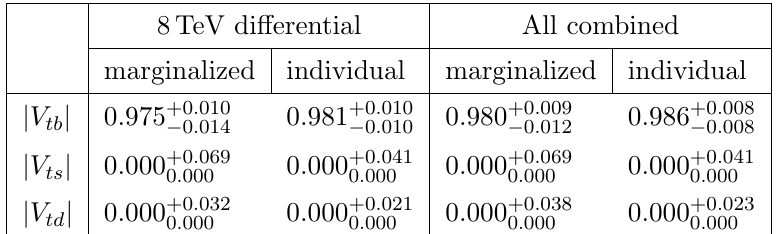
Table 3 . Observed individual and marginalized best (cid:12)t values together with 68% con(cid:12)dence interval for the j V td j , j V ts j and j V tb j CKM elements obtained from single top t -channel di(cid:11)erential cross section measurements at 8 TeV and from the combination of all LHC and Tevatron measurements (see table 1).